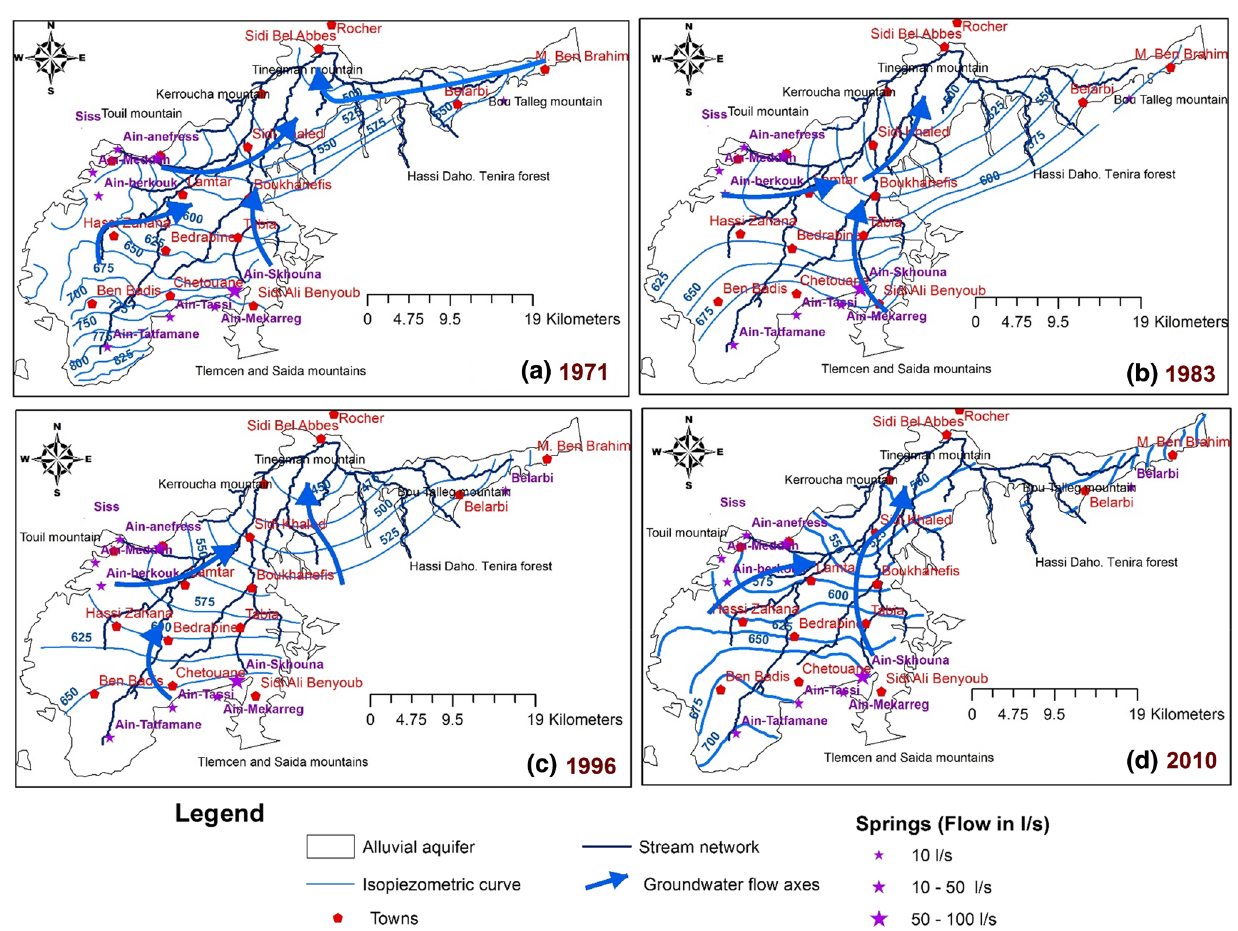
Fig. 10 Temporal evolution of the piezometric at the alluvial plain of Sidi Bel